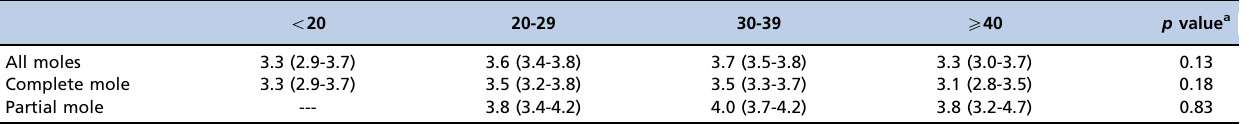
Table S2 - Comparison of hCG half-lives by age group among women with hydatidiform molar pregnancies with 95% Confidence Intervals. o 20 All moles